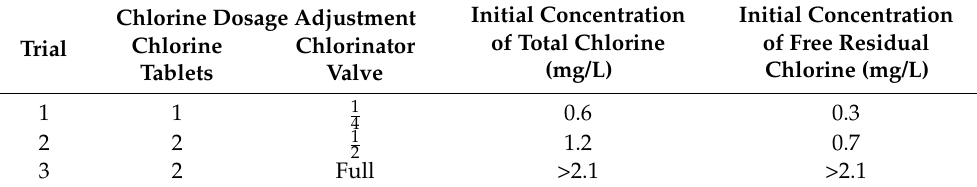
Table 2. Trial operations of chlorination